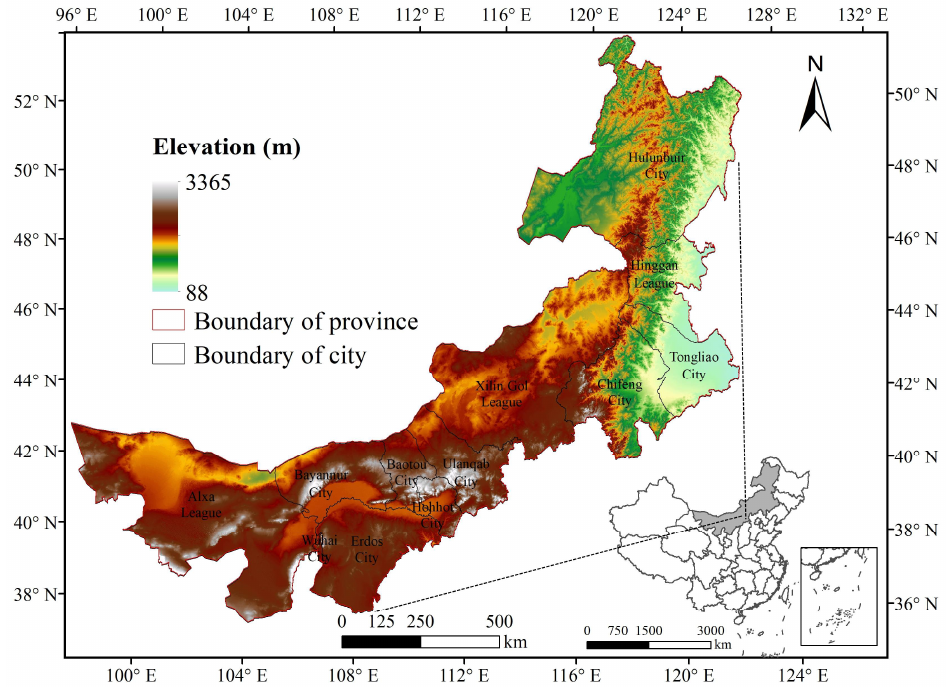
Figure 1. Location and digital elevation model (DEM) of Inner Mongolia.